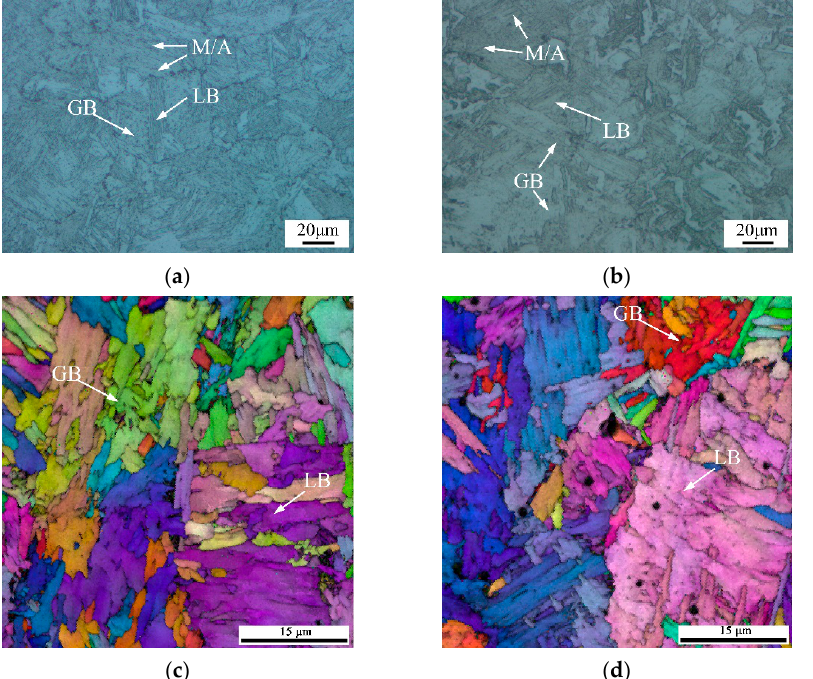
Figure 4. Microstructure of CGHAZ: ( a ) CGHAZ of welded joint; ( b ) CGHAZ after heat treatment; ( c ) EBSD of CGHAZ of welded joint; ( d ) EBSD of CGHAZ of heat-treated joint.